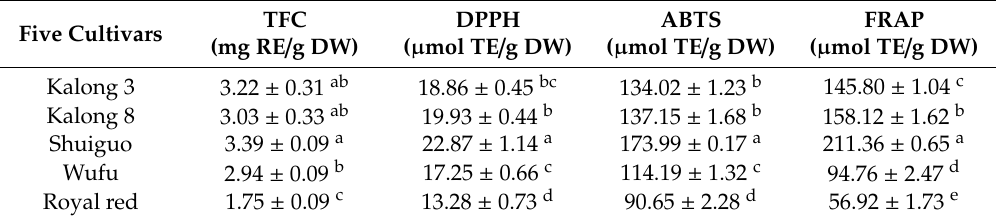
Table 1. Contents of total flavonoids (TFC), 2,2-diphenyl-1-picrylhydrazyl radical scavenging capacity (DPPH), 2,2 (cid:48) -azino-bis (3-ethylenzthiazoline-6-sulphonic acid) radical scavenging capacity (ABTS),